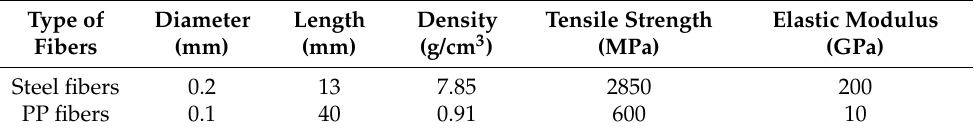
Table 2. Properties of fibers.